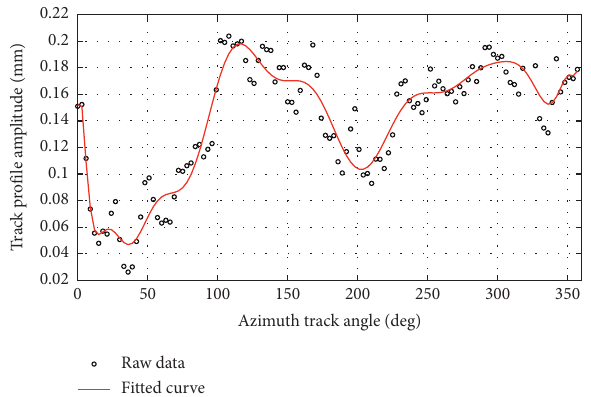
Figure 8: The azimuth track profile for the telescope with a 34 m diameter [24].